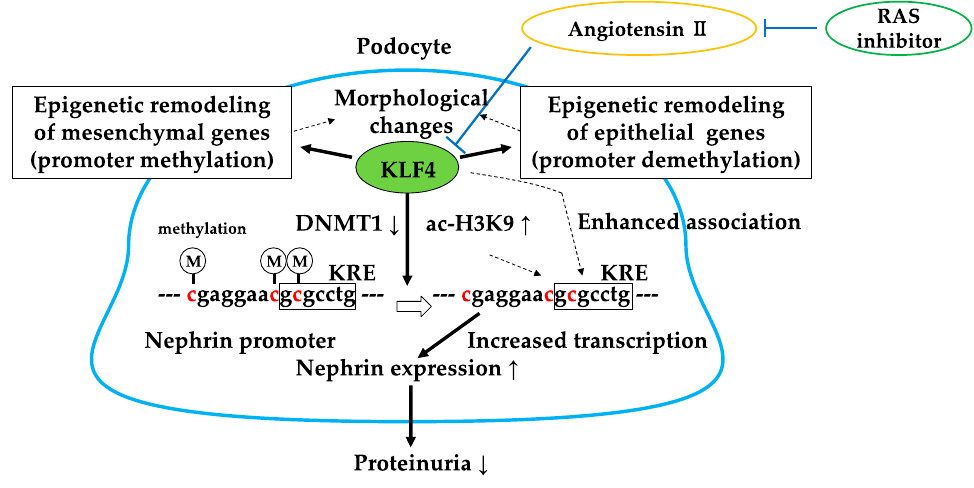
Figure 5. Gene-selective epigenetic regulation via KLF4. KLF4 regulates podocyte phenotype and function through decreased binding of DNMT1 and acetylation of H3K9 in the nephrin promoter region. Angiotensin II-mediated reduction of KLF4 is inhibited by RAS inhibitors. DNMT1 ↓ : decreased binding of DNMT1 in the nephrin promoter, ac-H3K9 ↑ : increased acetylation of H3K9 in the nephrin promoter. KRE: KLF4 response element.